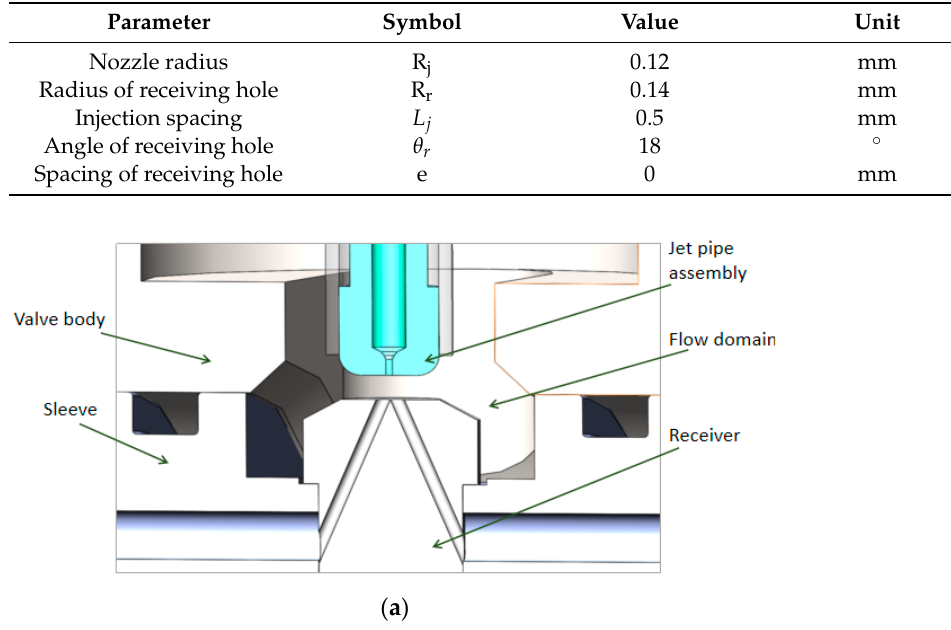
Figure 7. Cont Figure 7. Pre-stage flow field model: ( a ) 3D model; and ( b ) flow passage DM model. Table 1. Key structural parameter table.